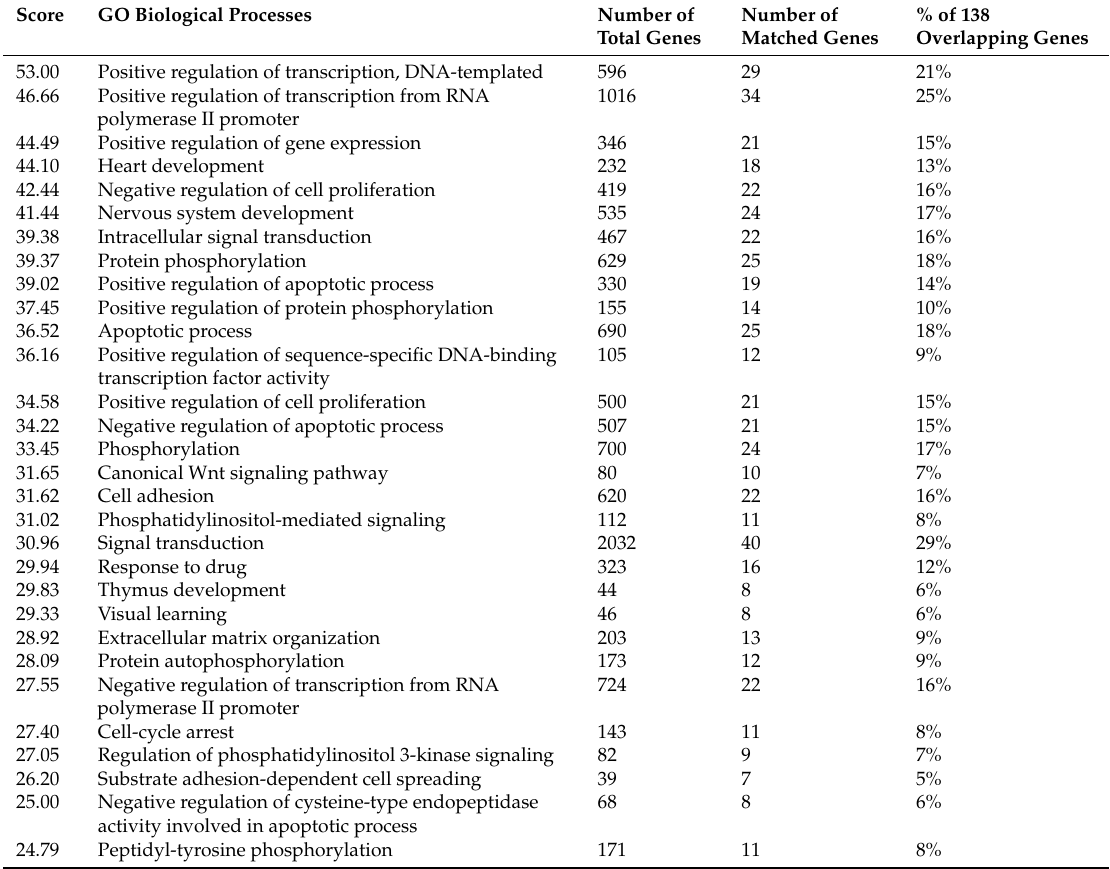
Table 3. Profiling of high scores in overlapping genes for autism and cancer-associated Gene Ontology (GO) biological